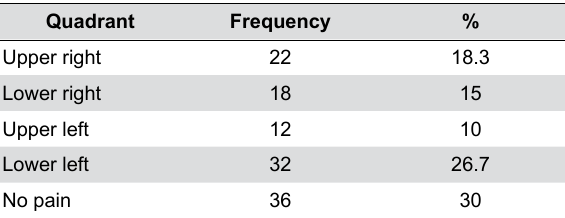
Table 3- Frequencies and percentages of tooth numbers in which the highest pain was